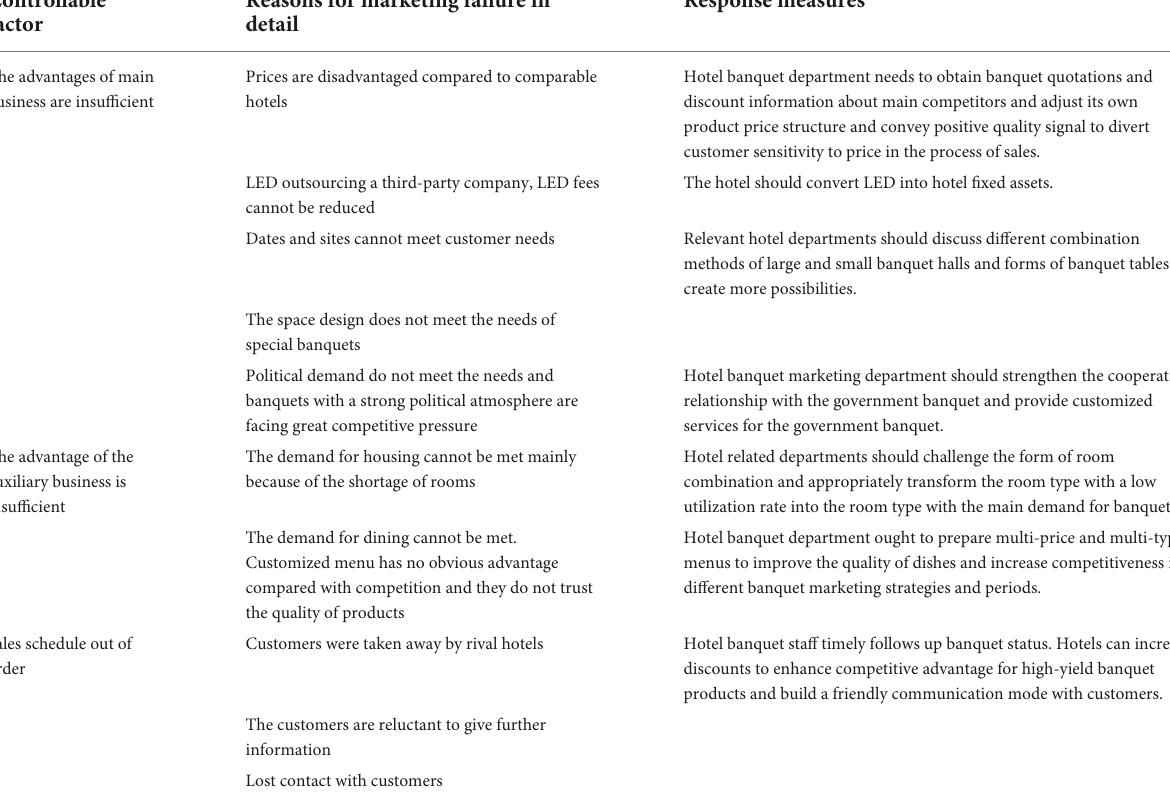
TABLE 4 Response measures for marketing failure in